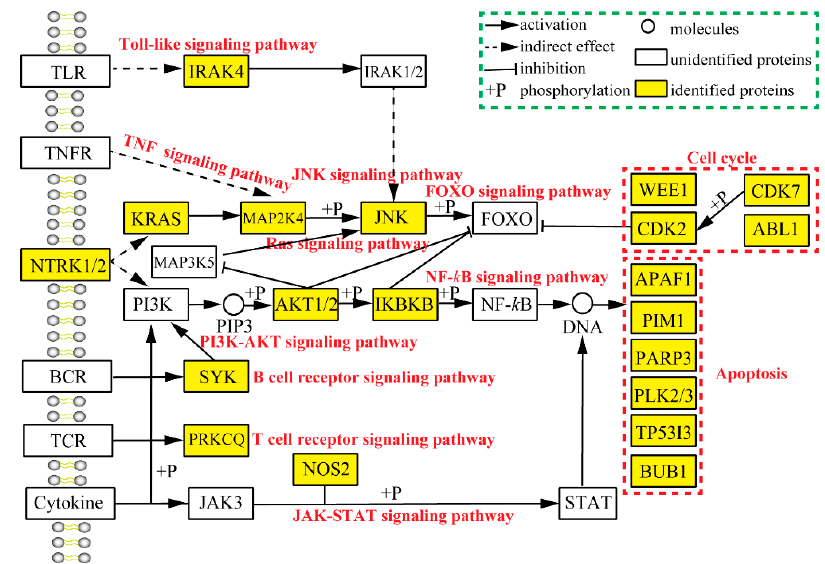
Figure 9. The schematic diagram of EGCG anti-tumor mechanisms based on reverse docking. The black solid arrows, dashed arrows and T-shaped lines represent the activation, indirect effect and inhibition, respectively. The circles, white rectangles and yellow rectangles represent the small molecules, unidentified proteins and identified proteins based on the result of top 40 target proteins through reverse docking. The red word represent the signaling pathway from KEGG terms.